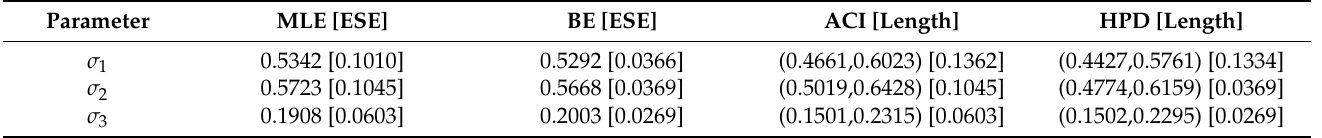
Figure 1. The PDF and CDF plots based on MOBR distribution with MLEs and BEs under Dataset 1. Table 9. Estimates for unknown parameters under Diabetic retinopathy